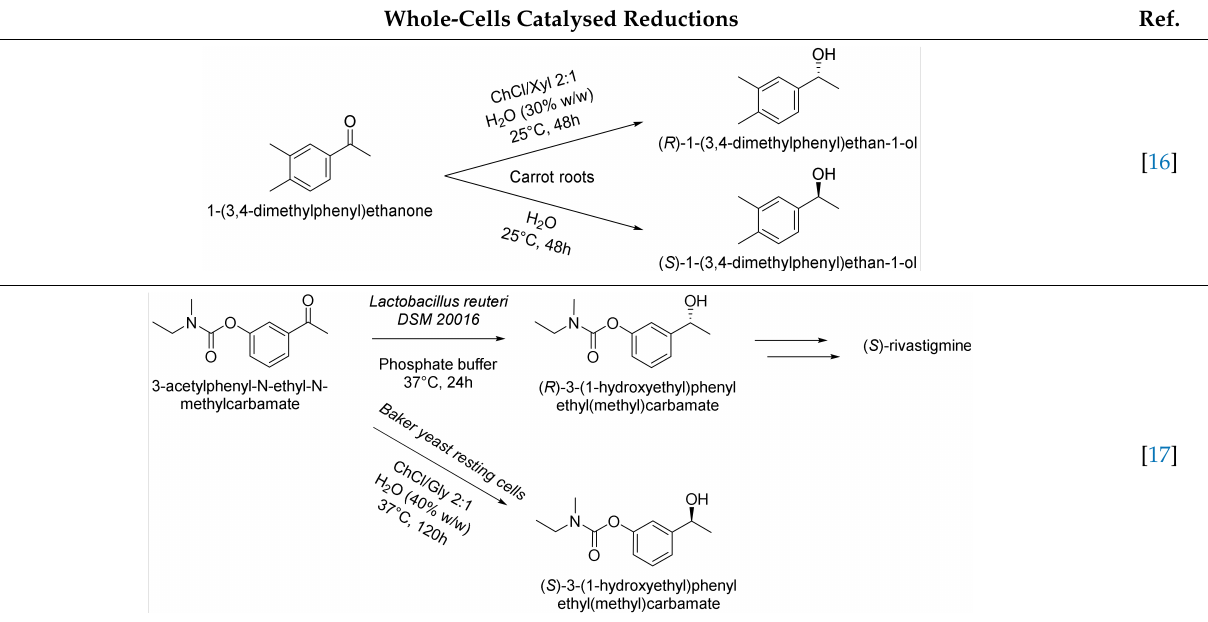
Table 2. Whole-cells catalysed